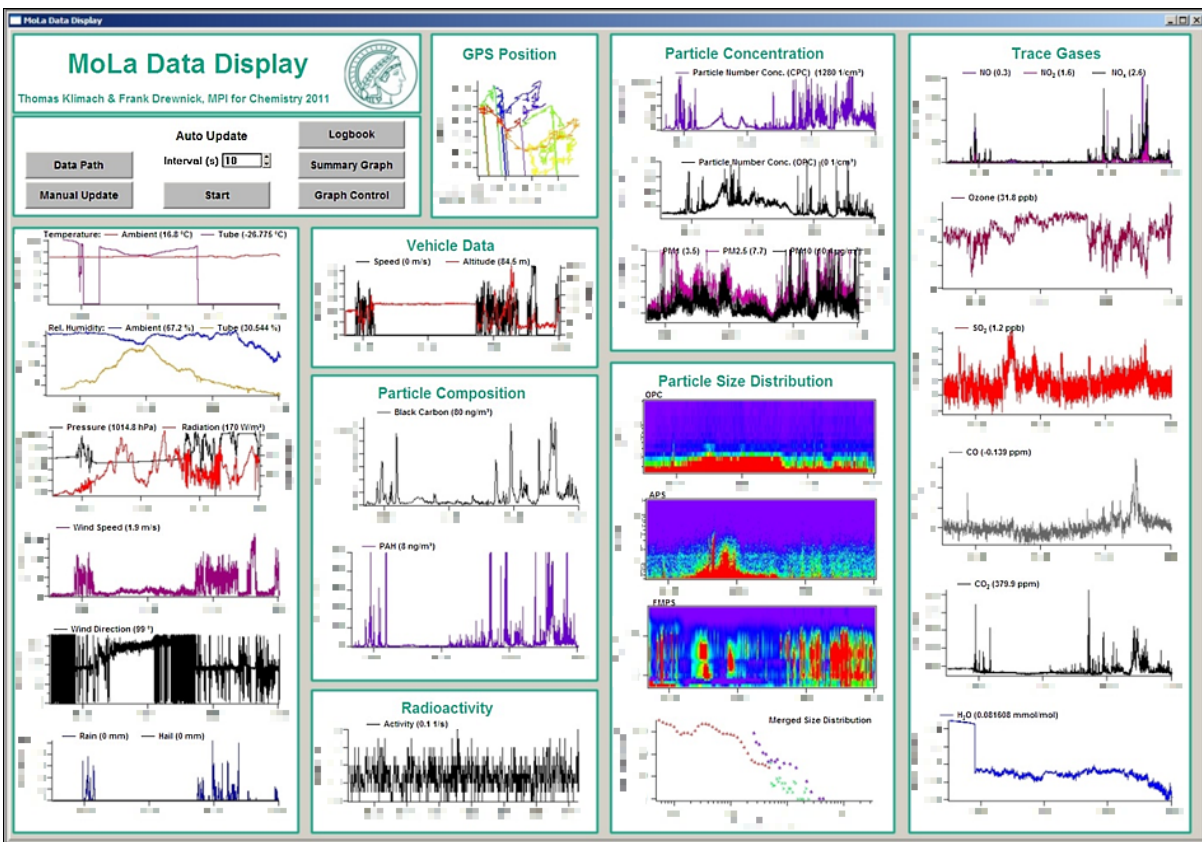
Fig. 5. Data live display tool of the mobile laboratory showing time series and current measurement data of all parameters (except AMS data and webcam image) on a single screen. Graph control, summary graphs and logbook functions are activated by buttons on the top